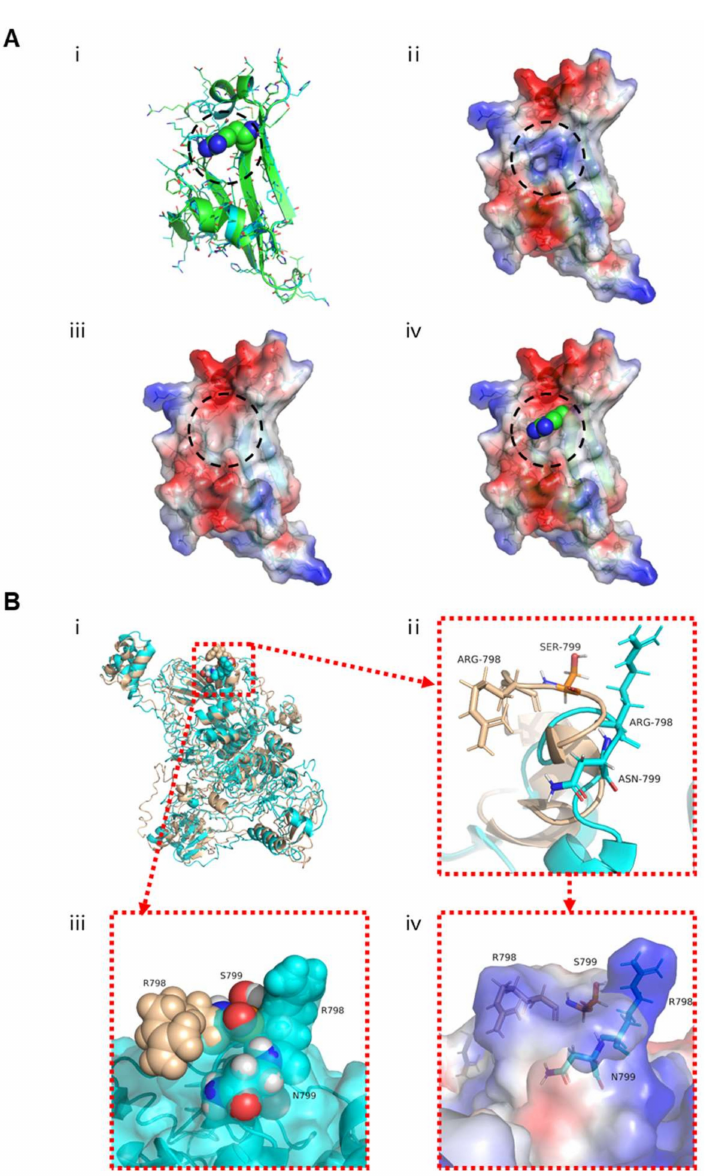
Figure 2. Effects of USP26 missense mutations on the structure of the USP26 protein. ( A ) The structure comparison of wild-type USP26 and the mutant Arg825Gly. (i) Structure comparison in cartoon images (Arg825 in spheres, wild-type in cyan, and mutant in green); (ii) MEP (molecular electrostatic potential) of the wild-type USP26 structure, (iii) MEP of the mutant Arg825Gly